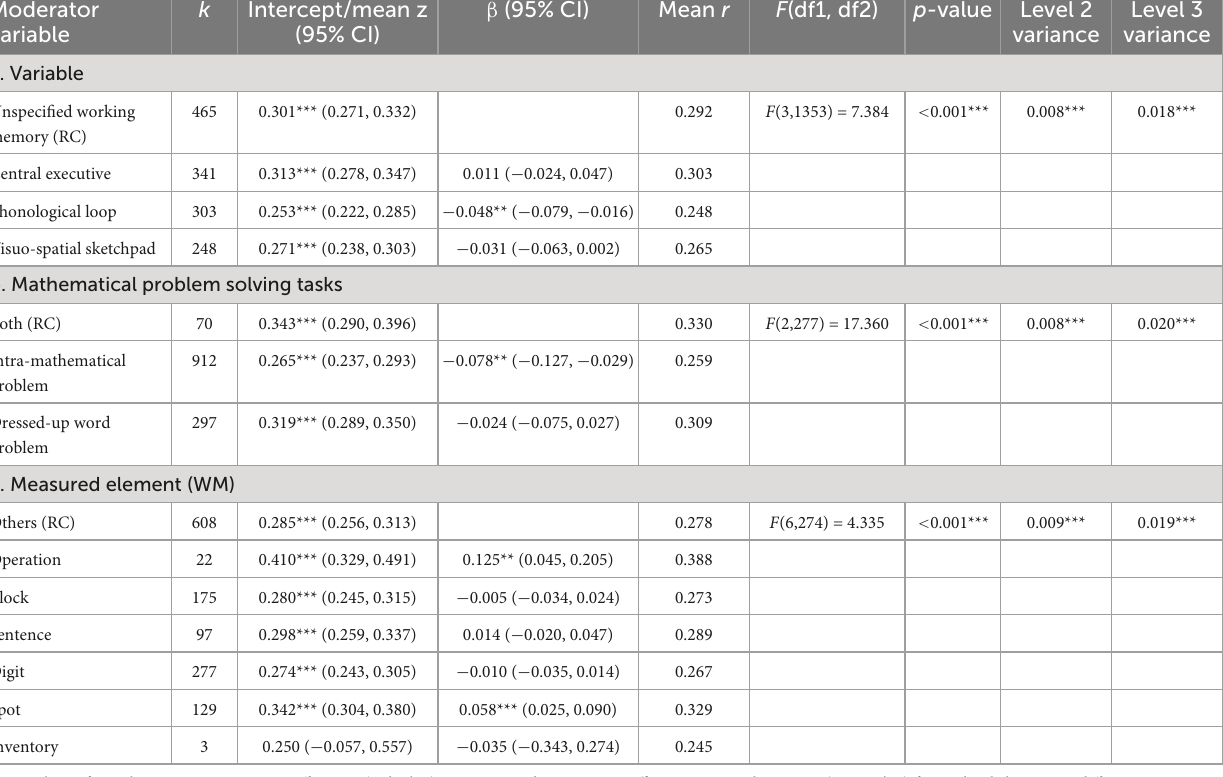
TABLE 1 Relation between working memory (WM) and task types.